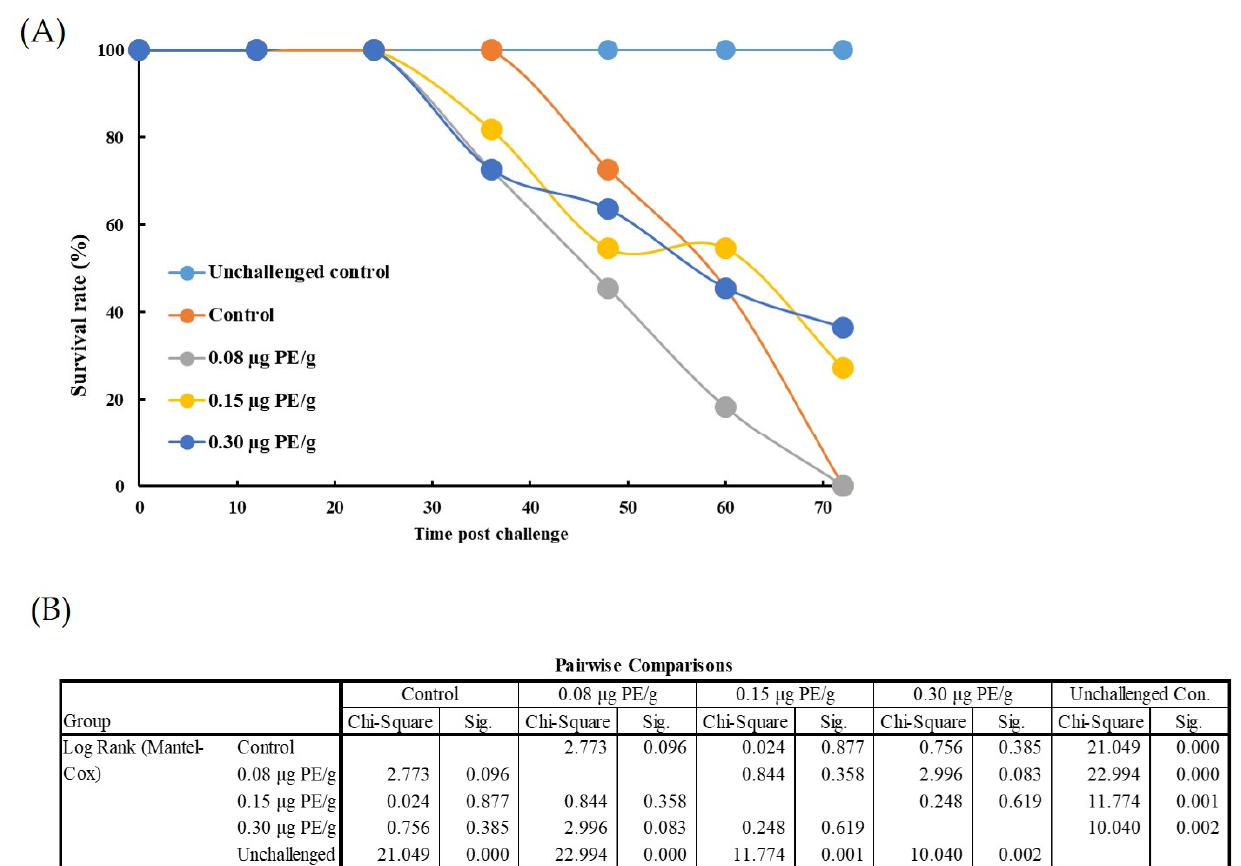
Figure 11. Effects of phycoerythrin (PE) (0, 0.30, 0.15, and 0.08 μ g/g body weight) on the survival rate of whiteleg shrimp ( Litopenaeus vannamei ) challenged with whiteleg spot syndrome virus (WSSV) during 72 h. The unchallenged control treatment was injected only with whiteleg shrimp saline solution (SSS), while other groups received SSS buffer containing 0, 0.30, 0.15, and 0.08 μ g of PE per gram of body weight prior to be challenged with WSSV (9.19 × 10 4 copies per shrimp). ( A ) Survivorship curves for whiteleg shrimp after challenged by WSSV. ( B ) Differences among the groups were assessed using the Mantel–Cox test for pairwise comparisons.